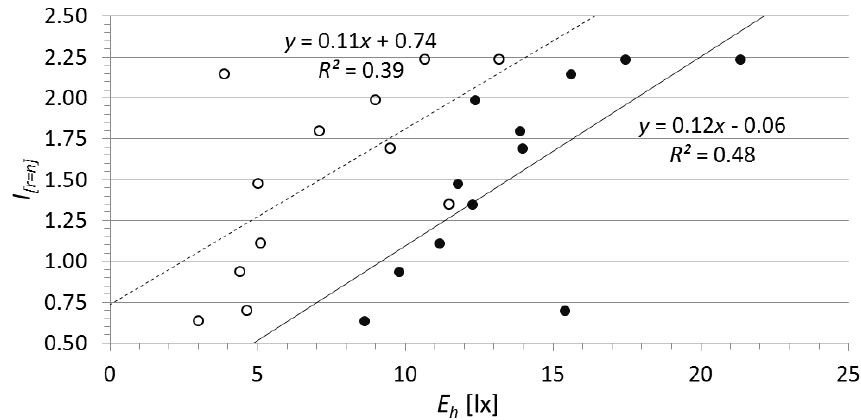
Figure 15. Scenario 2 (design status): correlation between I and L av .